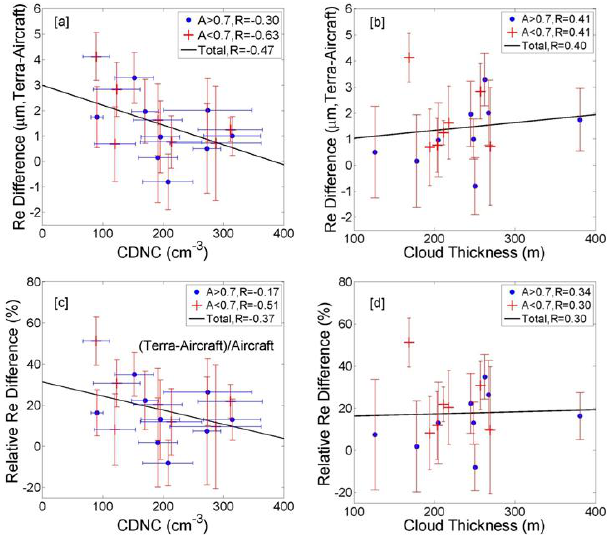
Fig. 6. The difference and relative difference between Terra- MODIS retrievals and aircraft measurements of cloud effective ra- dius ( R e ) as a function of cloud drop number concentration (CDNC) and cloud geometric thickness.